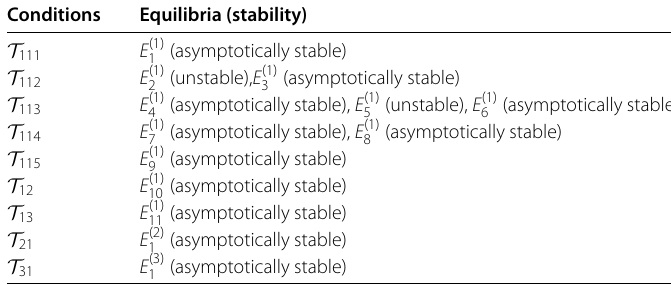
Table 2 Stability of the equilibrium points for